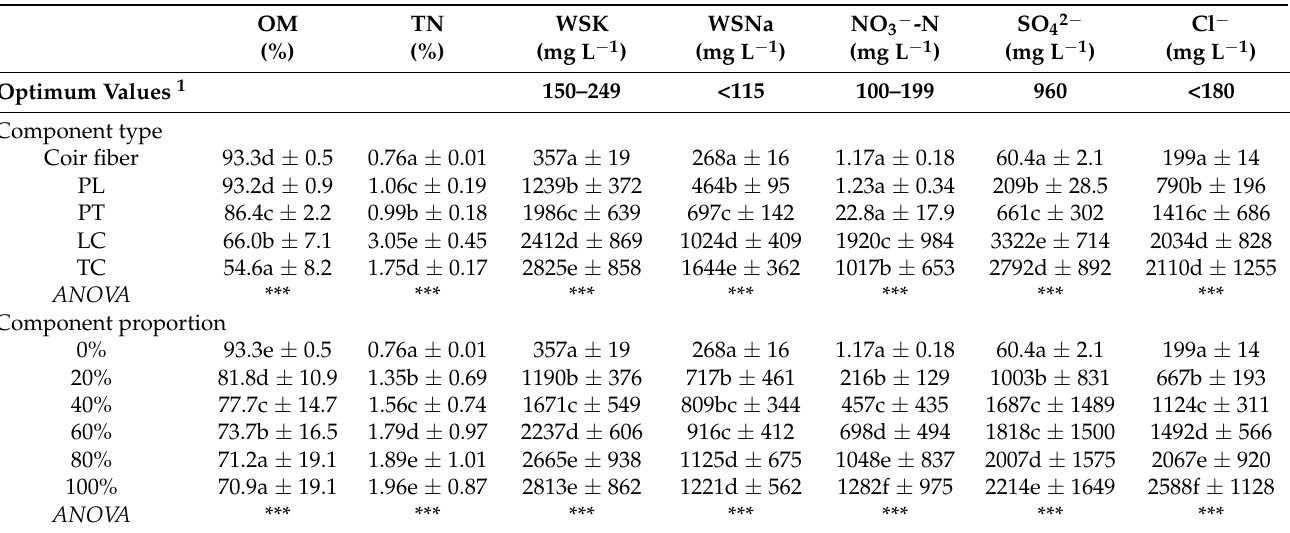
Table 3. Effect of the type and proportion of the organic materials considered for the principal chemical characteristics of the growing